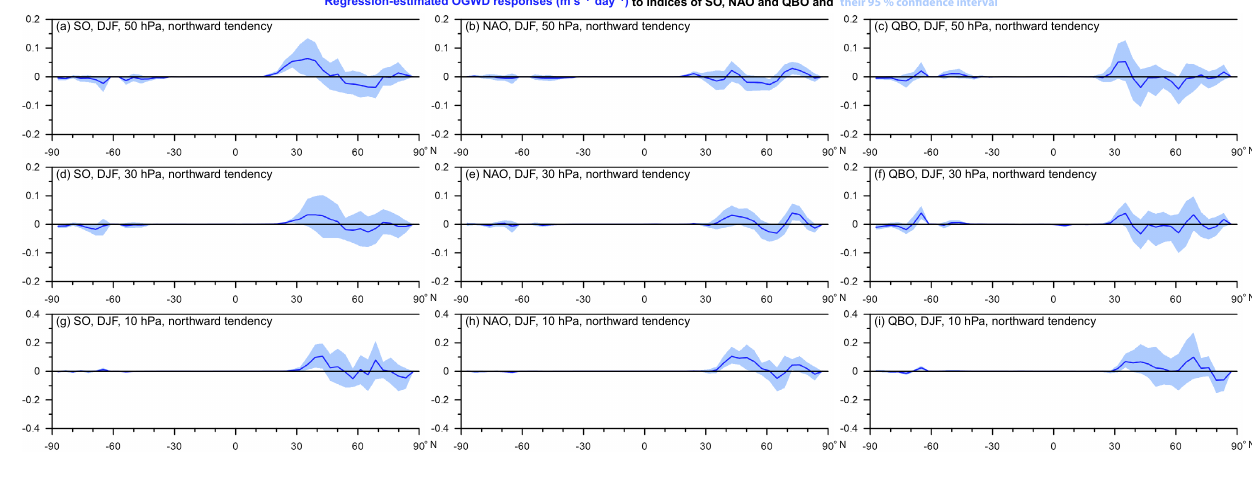
Figure 6. Response of the meridional mean OGWD (ms − 1 day − 1 ) at the 50hPa (a, b, c) , 30hPa (d, e, f) and 10hPa (g, h, i) level related to the activity of the Southern Oscillation (a, d, g) , North Atlantic Oscillation (b, e, h) and quasi-biennial oscillation (c, f, i) . The responses correspond to the increase in the oscillation index by 4 times its SD, i.e., to the transition of the respective oscillation from a highly negative to a highly positive phase; the blue curve shows the signal value and blue shading illustrates the 95% confidence interval. Analysis period: 1979–2010, monthly data, DJF